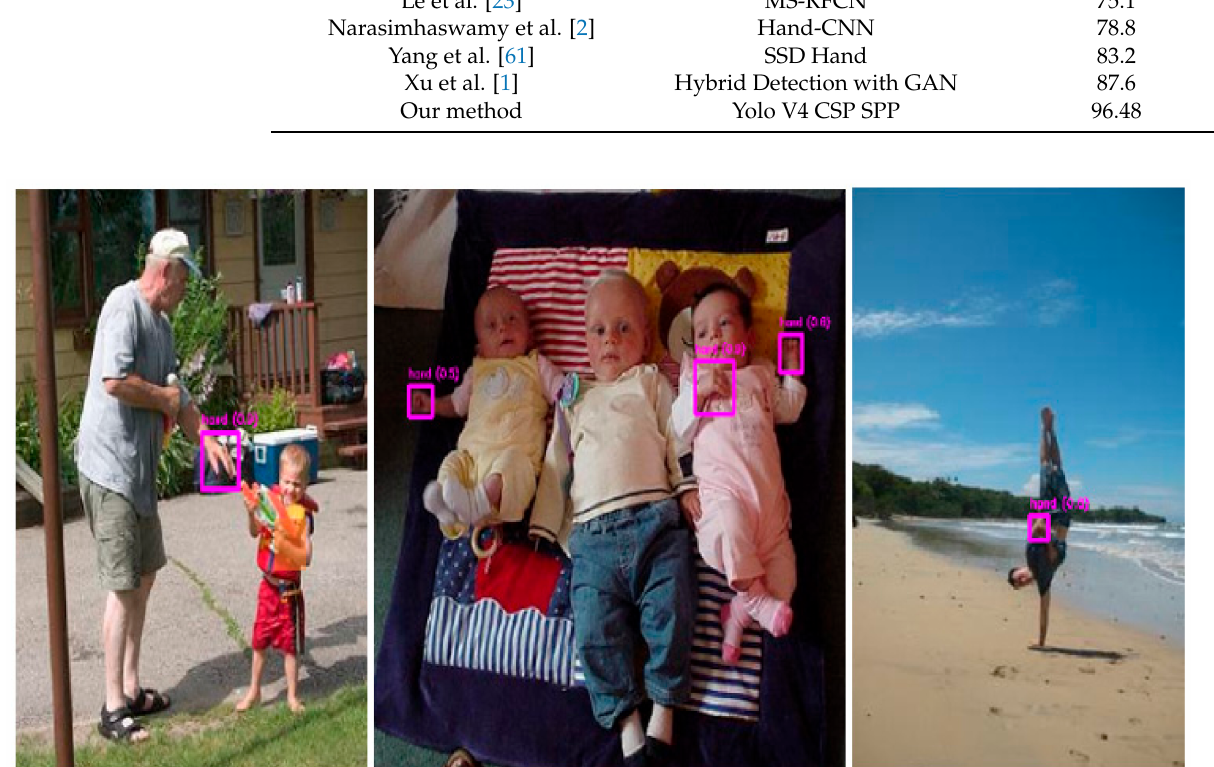
Figure 9. Yolo V4 CSP SPP failure cases on Oxford hand dataset.